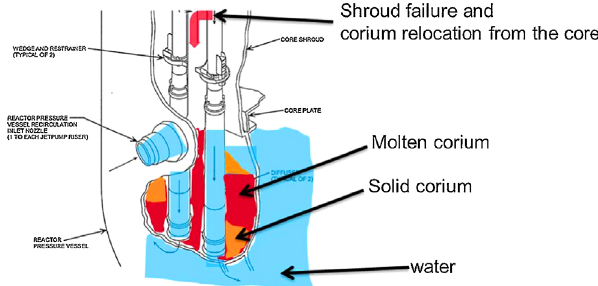
Fig. 6. Zoom of the corium relocation in the SEA: ∼ 6 h 40 after the reactor